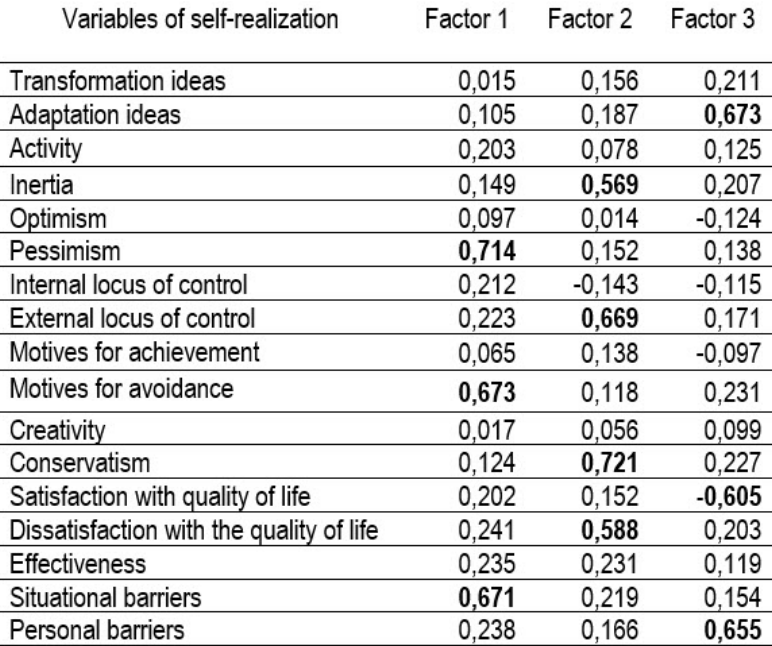
Factor structure of the variables of self-realization among students with negative and rigid type of self-evaluation (n =